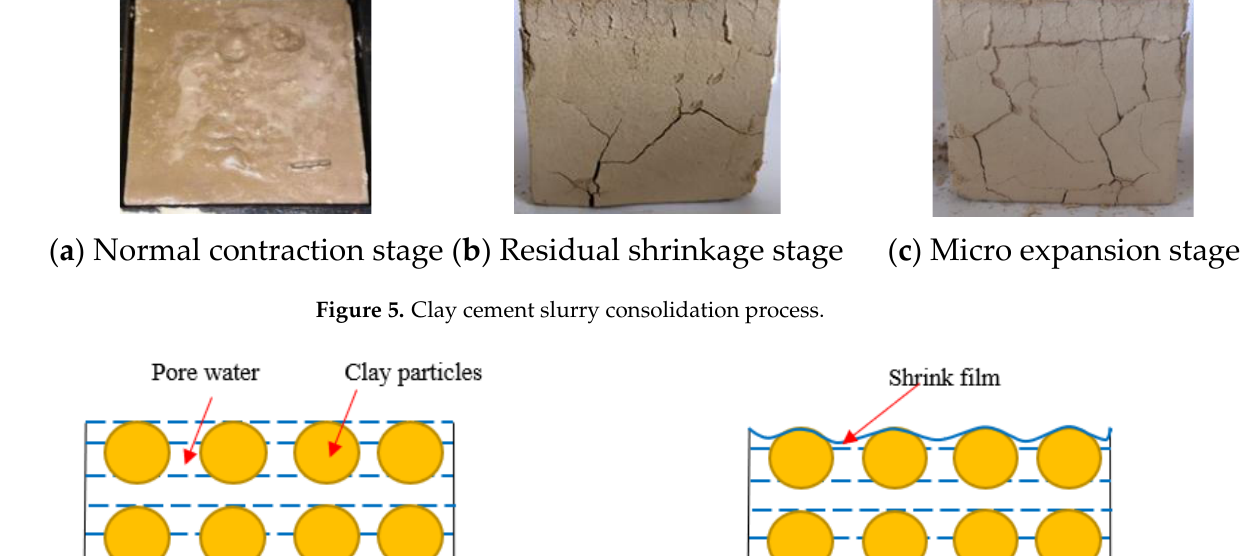
Figure 5. Clay cement slurry consolidation process.